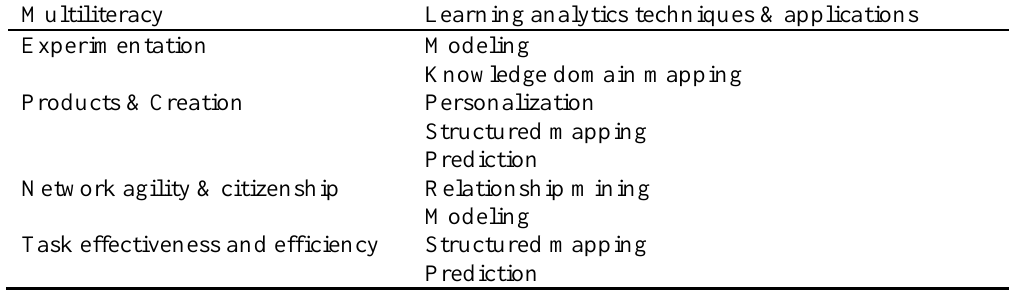
Mapping Multiliteracies to Learning Analytics Techniques and Applications Multiliteracy Learning analytics techniques &